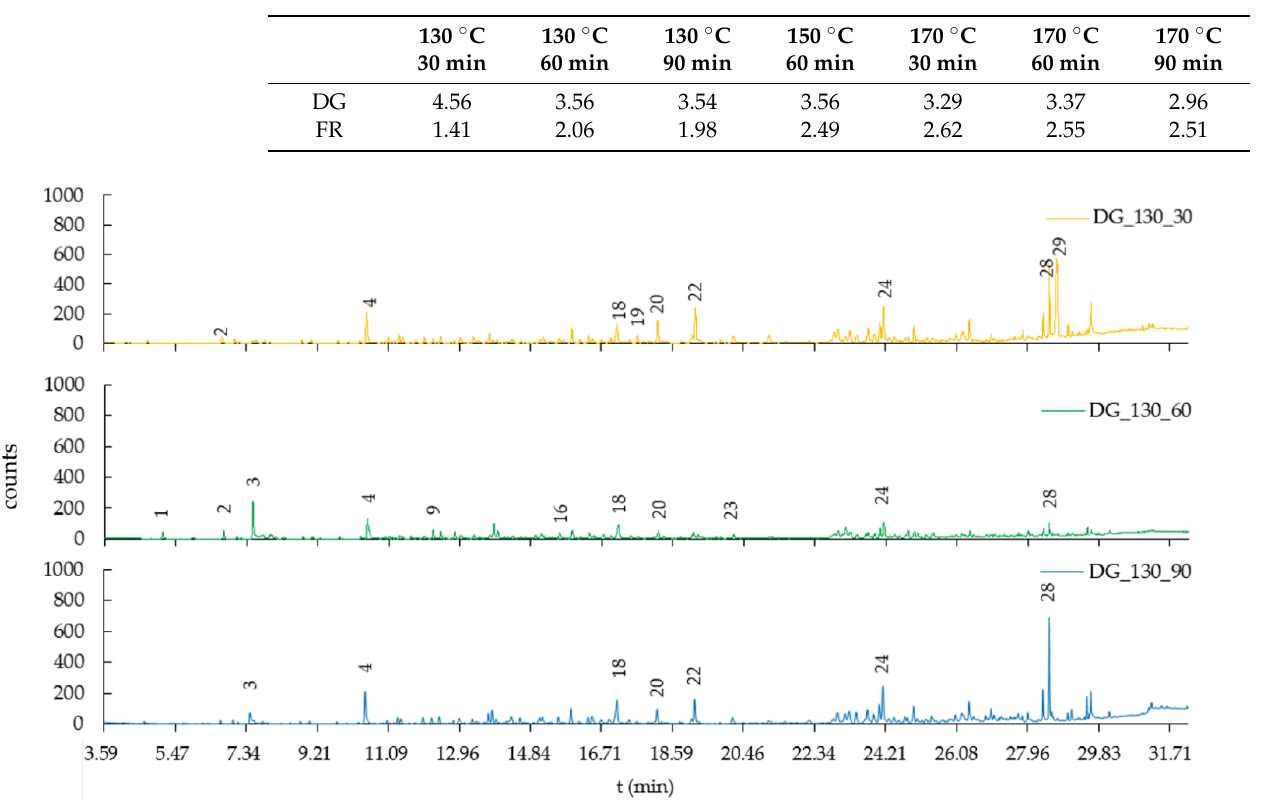
Figure 2. GC-MS diagram of the digestate (DG) hydrothermally treated at 130 °C with 30, 60 and 90 min holding times, see peak numbers in Table 6.